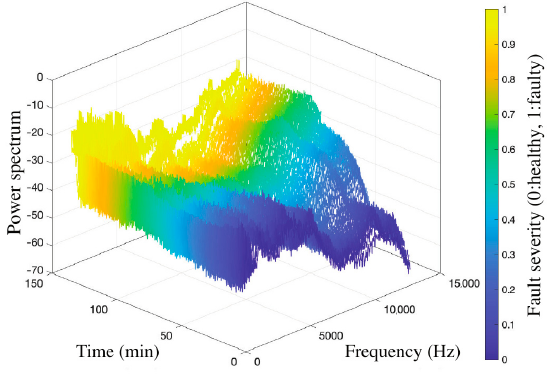
Figure 3. Power spectrum over time and frequency of Bearing B _ 2 .